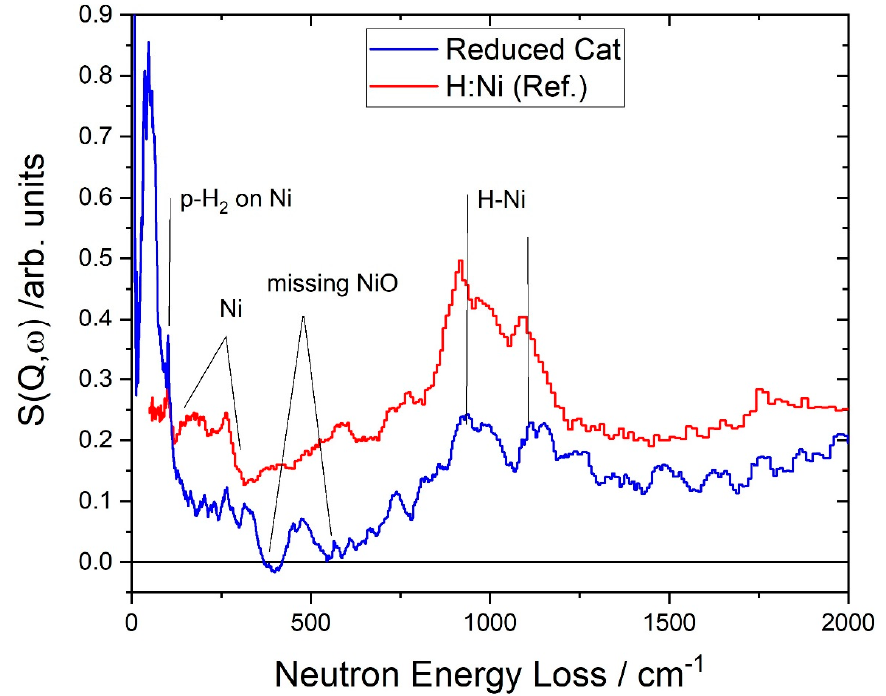
Figure 6. INS di ff erence spectrum of reduced Ni on alumina / silica (blue curve, reduced catalyst minus Figure 6. INS difference spectrum of reduced Ni on alumina/silica (blue curve, reduced catalyst minus background, for measurement procedure see Figure 2) compared to a reference spectrum of hydrogen exposed Raney nickel catalyst (red curve, from